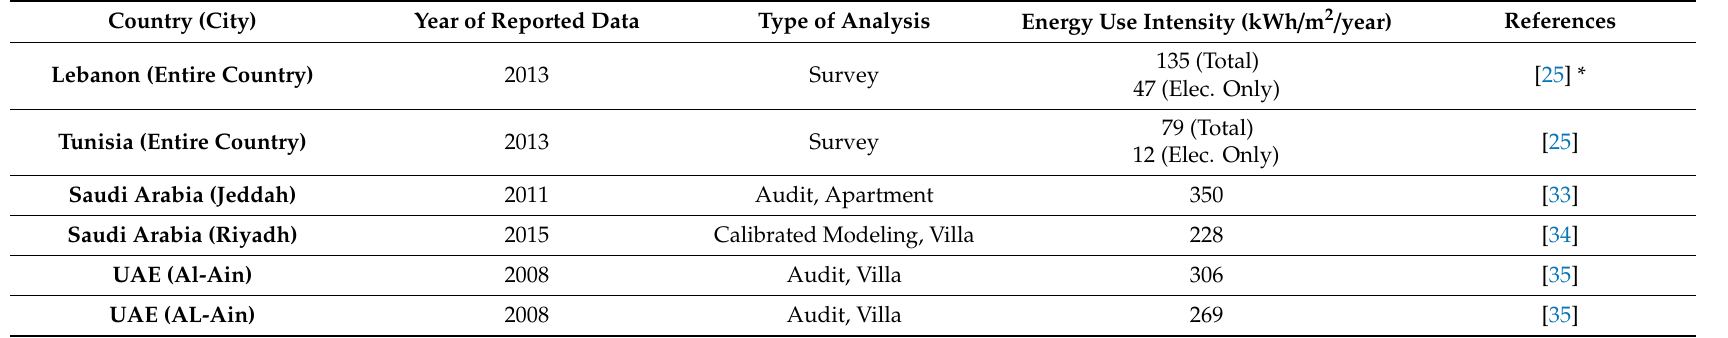
Table 11. Reported EUI values for residential buildings in select Arab